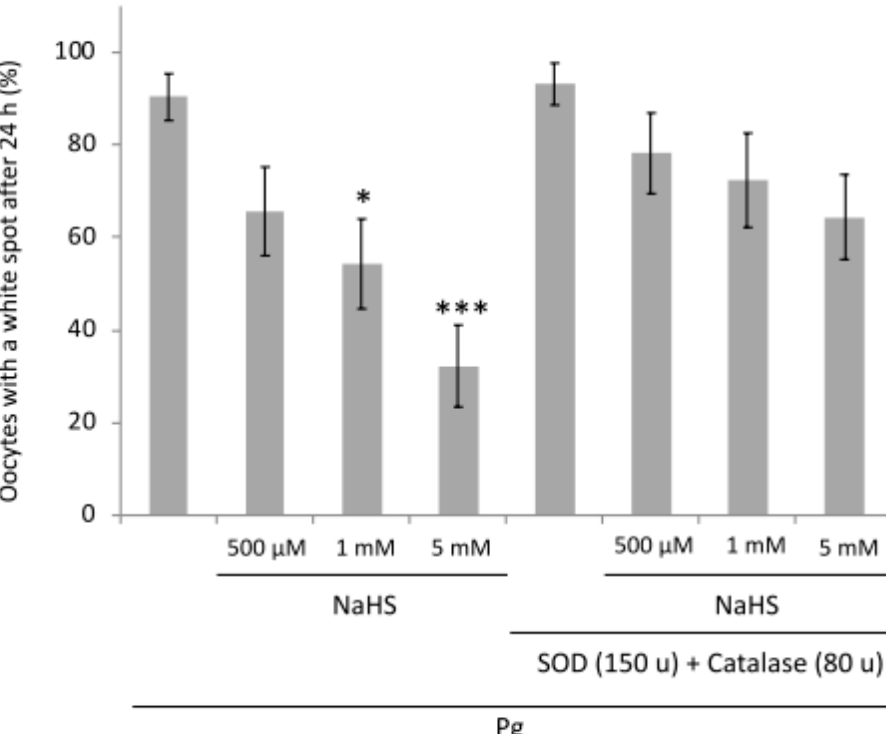
Figure 8. NaHS effects on meiosis resumption are reversed by ROS scavengers. Percentage of oocytes with a white spot 24 h after addition of progesterone (4 μ g/mL). Oocytes were pre-incubated (or not) in the presence of NaHS at different concentrations and rescued with supplementation by SOD (150 units) and catalase (80 units). Statistical significance was accepted for * p < 0.05 and *** p < 0.001. N = 3; n = 15.